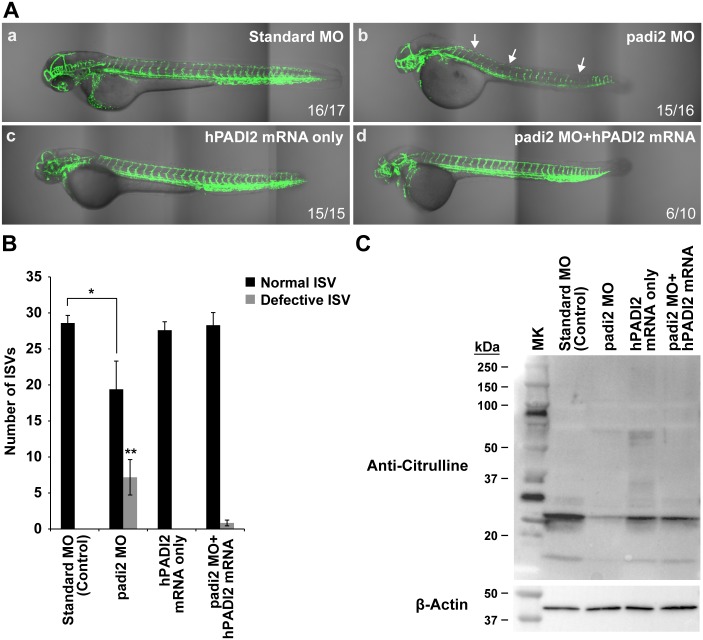
Human PADI2 mRNA can rescue vessel defects in zebrafish padi2 morphants.A) Significant vascular defects (arrows) are present in padi2 MO (1.5 ng/embryo) (b) compared to standard (sham-injected) MO control (1.5 ng/embryo) (a) and human PADI2 (hPADI2) mRNA only (225 pg/embryo) (c). Co-injection of hPADI2 mRNA (225 pg/embryo) rescues padi2 MO (1.5 ng) vascular defect. (d) Magnification: x10. B) Bar graph of normal and defective ISVs in four different groups, showing average ±SD from four independent experiments. Missing and abnormal formation of ISVs are considered as defective vessels. The number of defective vessels is significantly increased with the injection of padi2 MO (* and ** denotes P<0.001 and P<0.005 respectively.) C) Citrullination levels in zebrafish. The level of deiminated protein is partially rescued in padi2 morphants with the co-injection of hPADI2 mRNA.